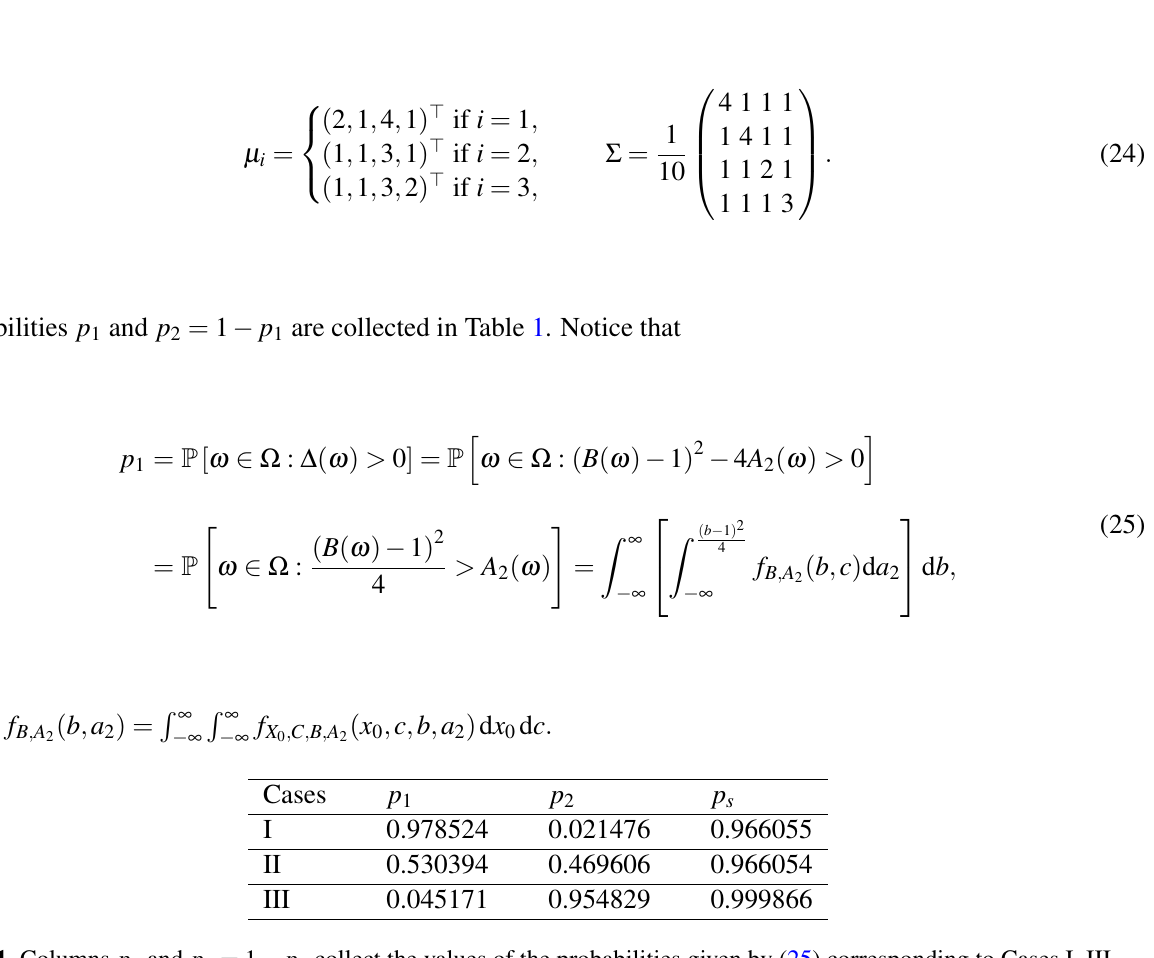
Table 1 Columns p 1 and p 2 = 1 − p 1 collect the values of the probabilities given by (25) corresponding to Cases I–III, when J i ∼ N ( µ i , Σ ) , being µ i and Σ specified in (24). Values of p s represent the probabilities associated with asymptotic stability according to